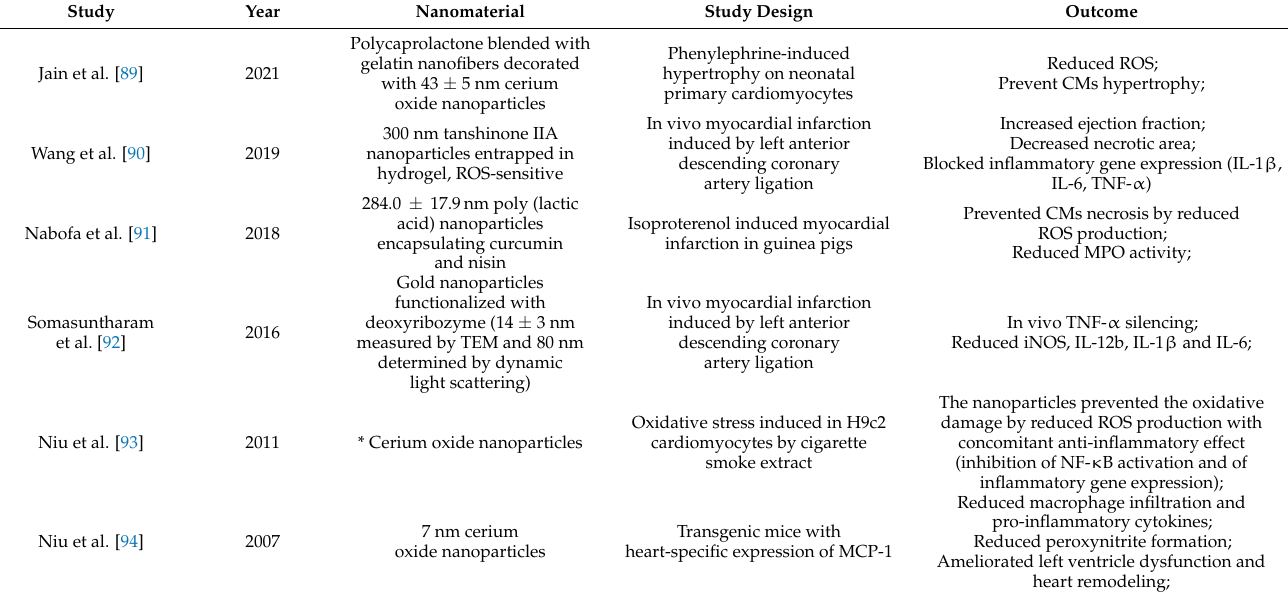
Table 4. Reducing oxidative stress and inflammation by using nanoparticles in cardiovascular